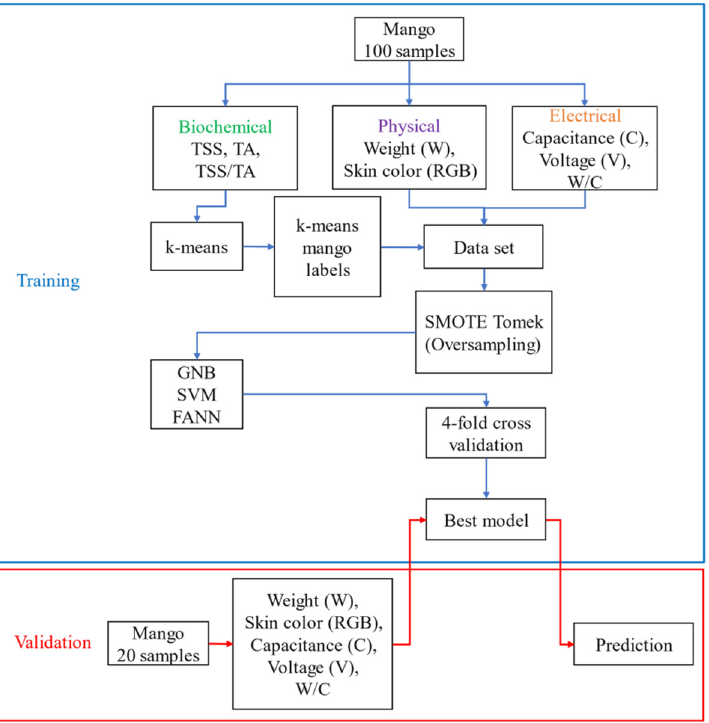
Figure 3. The procedures for predicting the ripeness stage of mangoes.